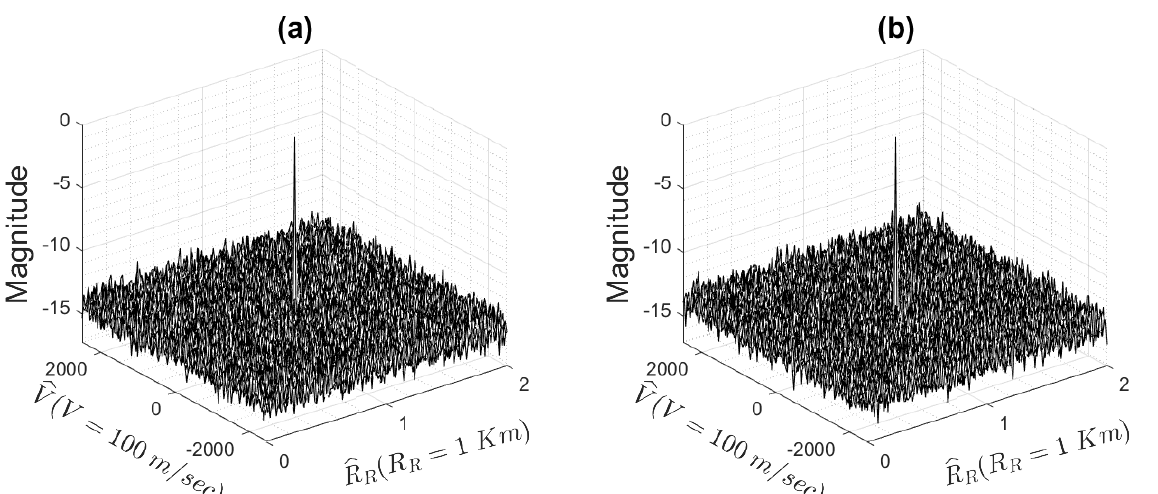
Figure 17. Ambiguity surface of the monostatic radar for ( a ) the Lorenz CBFM waveform and ( b ) the Burke–Shaw CBFM waveform considering SNR = − 30 dB.